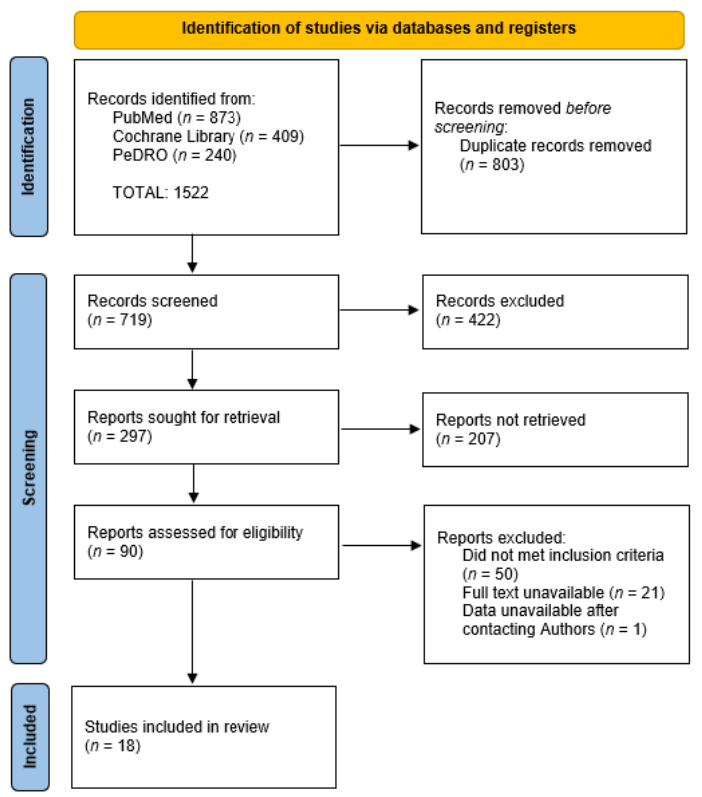
Figure 1. Flow diagram representing the study selection process for the meta-analysis.